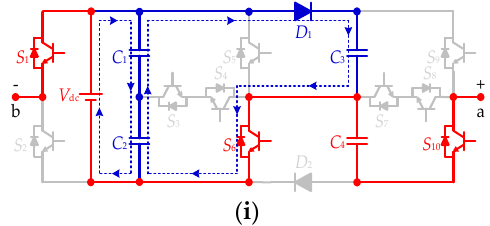
Figure 5. Operating modes. ( a ) +2 V dc , ( b ) +1.5 V dc , ( c ) + V dc , ( d ) +0.5 V dc , ( e ) 0, ( f ) − 0.5 V dc , ( g ) - V dc , ( h ) − 1.5 V dc , ( i ) − 2 V dc .